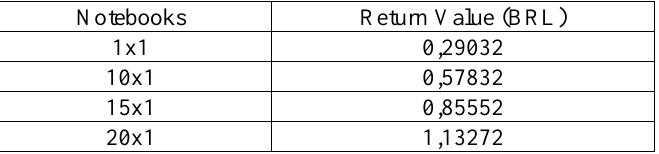
Table 2: Values by notebook